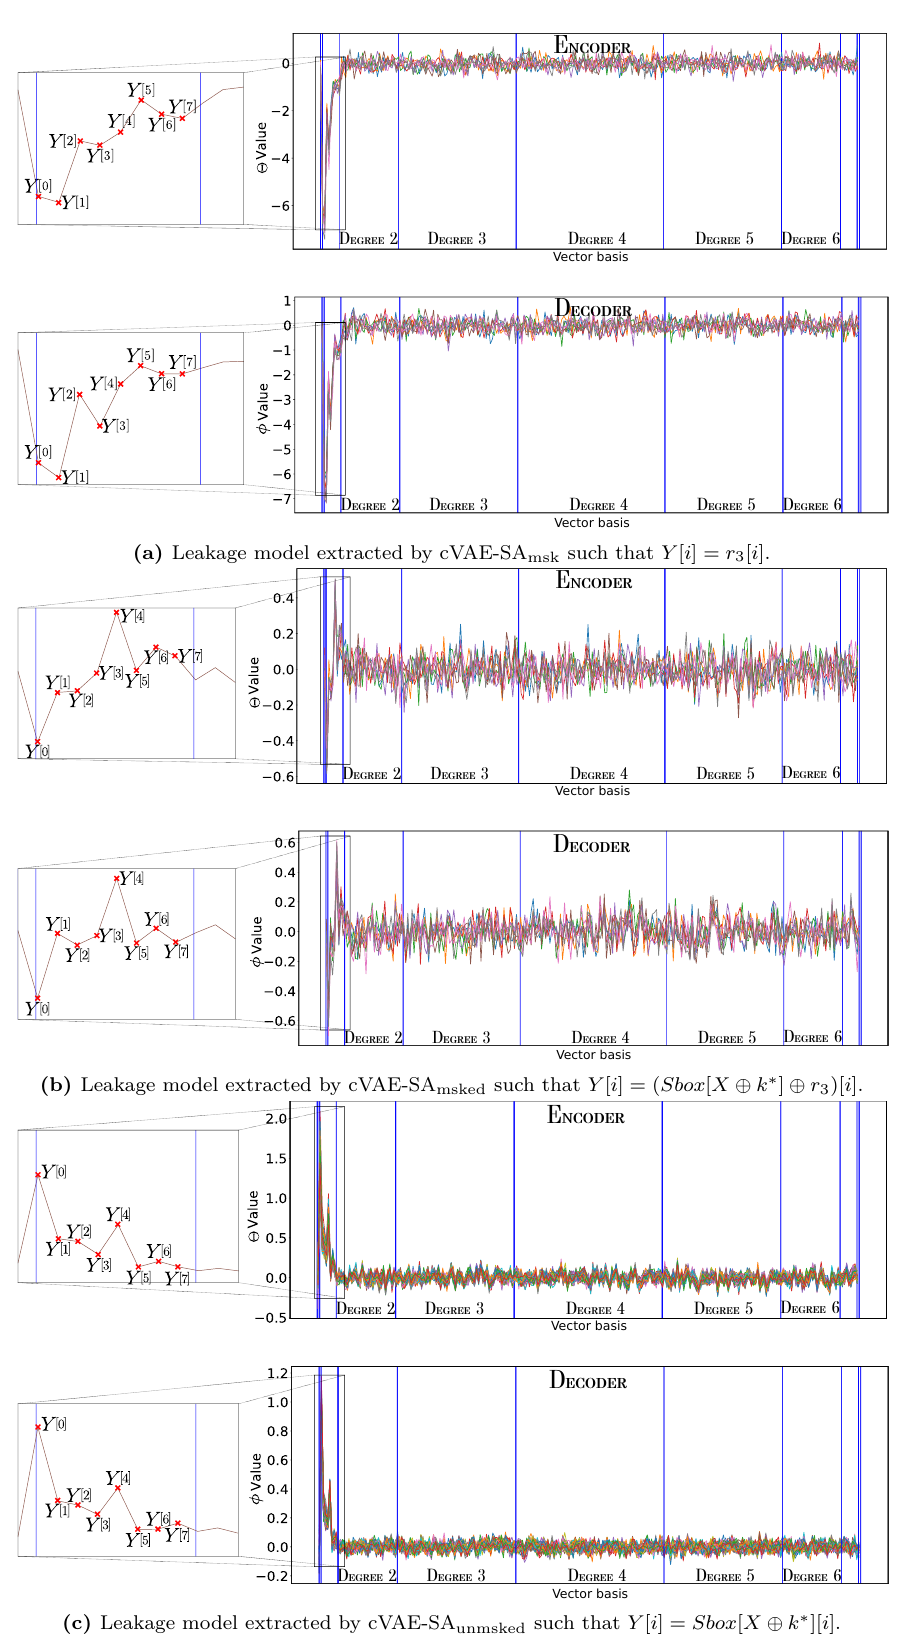
Figure 12: Leakage model extracted depending on the targeted